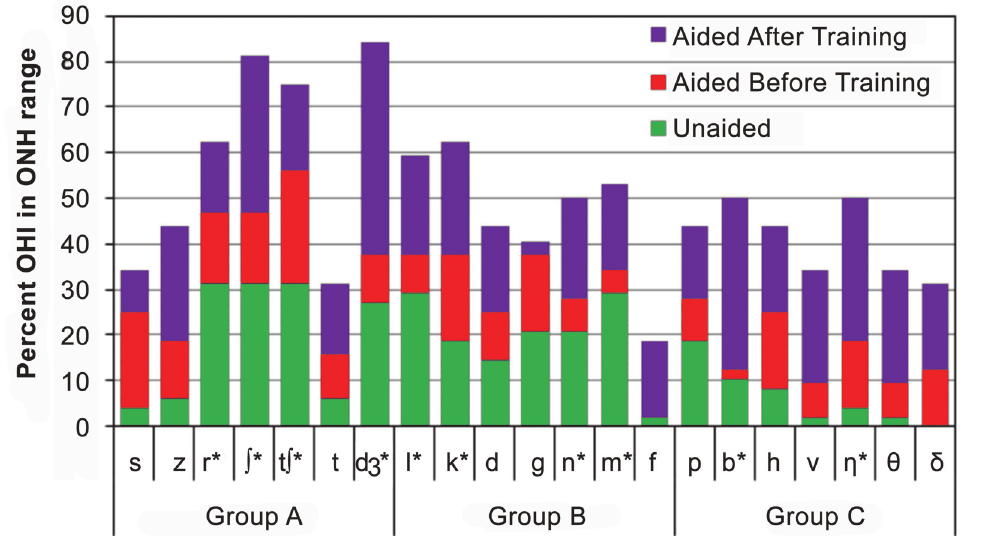
Fig 7. The percentage of OHI listeners whose thresholds were within the range of 16 ONH listeners. OHI data are shown for unaided listening, aided listening, and aided listening after training. Asterisks mark consonants where at least 50% OHI were in the range of ONH listeners after